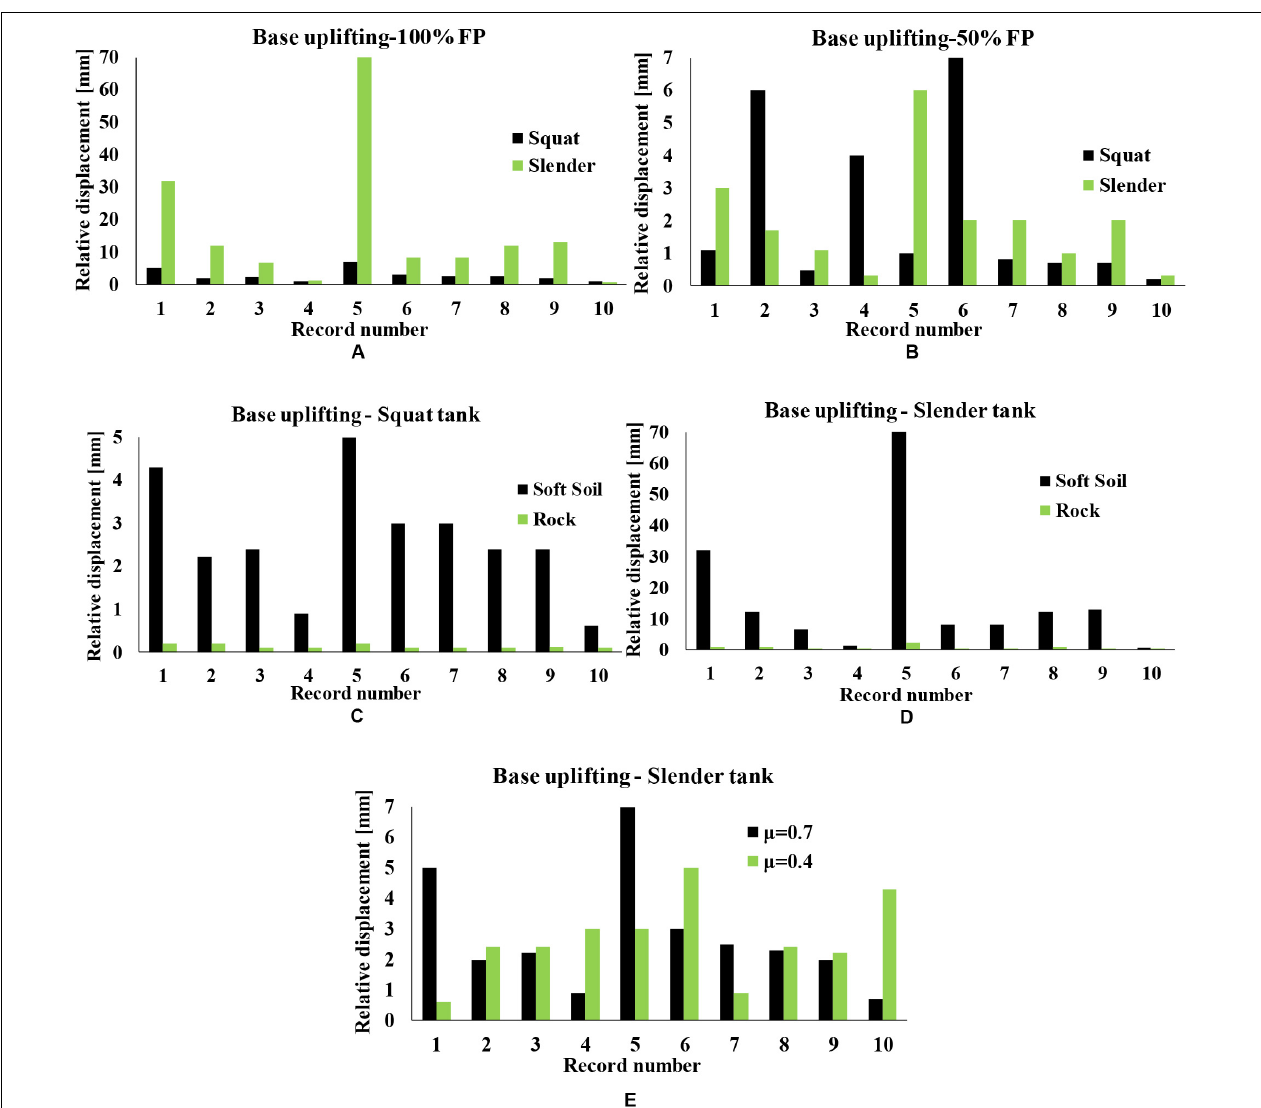
FIGURE 10 | Base uplifting results of (A) 100% FP and (B) 50% squat and slender tank, (C) squat and (D) slender tank for different foundation layer types, and (E) comparison of friction coefficient for the unanchored slender tank.